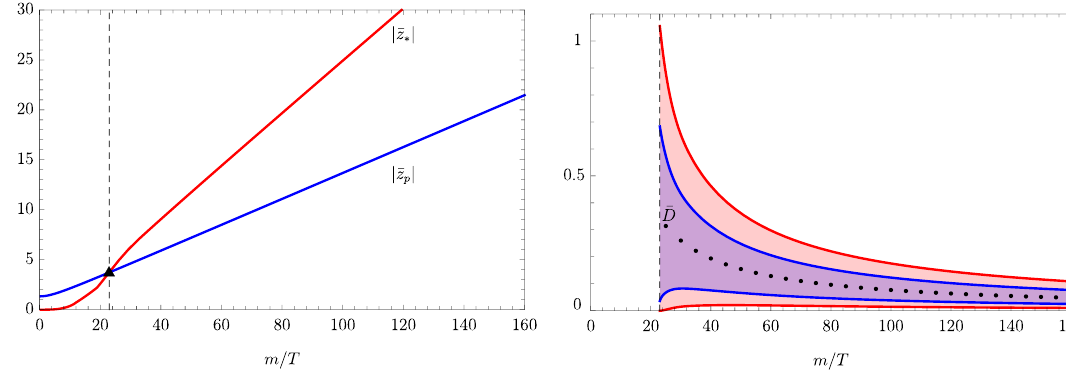
Figure 3 . Left panel: a plot of the radius of convergence R = | ¯ z ∗ | , where z ∗ denotes the leading critical point, and the absolute value of the location of the pole-skipping point | ¯ z p | as a function of m/T . The point at which the pole-skipping point enters the convergence disk is denoted by a black triangle. Eq. (4.7) can only be applied to the region on the right of the vertical dashed line. Right panel: bounds on energy diffusion for different values of m/T using pole-skipping. The blue band indicates the logarithmic bounds from eq. (4.6). For comparison, in red, we also show the looser bounds from eq. (4.7). The black dots represent the actual values of ¯ D computed